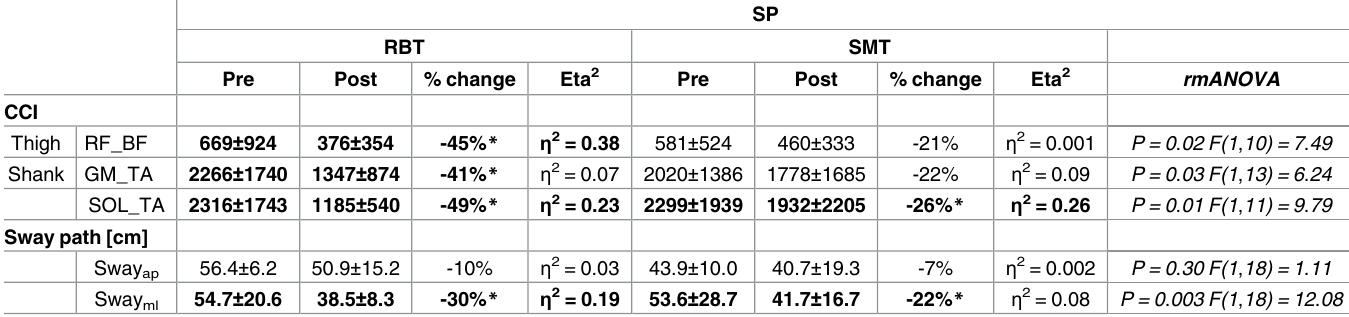
Co-contraction Index In both groups in all three protocols (ST, SP, CI), CCIs in the muscles encompassing the ankle joint GM_TA (SMT -33%, -22%, -32%; RBT -14%, -41%, -18%) and SOL_TA (SMT -32%, -26%, -39%; RBT -22%, -49%, -20%) were significantly reduced, with greater effect sizes for SMT, respectively. CCIs in RF_BF were significantly reduced in both groups during ST and SP protocols, with large effect sizes for RBT, whereas the SMT group showed very small effect sizes for thigh CCI reduction in both test protocols. Further, a greater reduction was observed for the SMT-group during ST (SMT -36%; RBT -18%), and for the RBT-group during SP (SMT -21%; RBT -45%) (Fig 2B). Moreover, post hoc analyses revealed that the reduction in thigh CCIs (RF_BF) for both SP and the transfer condition CI was only significant in the RBT- group, whereas the SMT-group showed no significant RF_BF reduction in thigh CCI in these two protocols (see Fig 2B). Between group comparisons revealed no significant results. Table 2. Pre and post values of the co-contraction indices (CCIs) and the platform sway path during Protocol 2 on the swinging platform (SP) are illustrated for the two groups RBT and SMT.